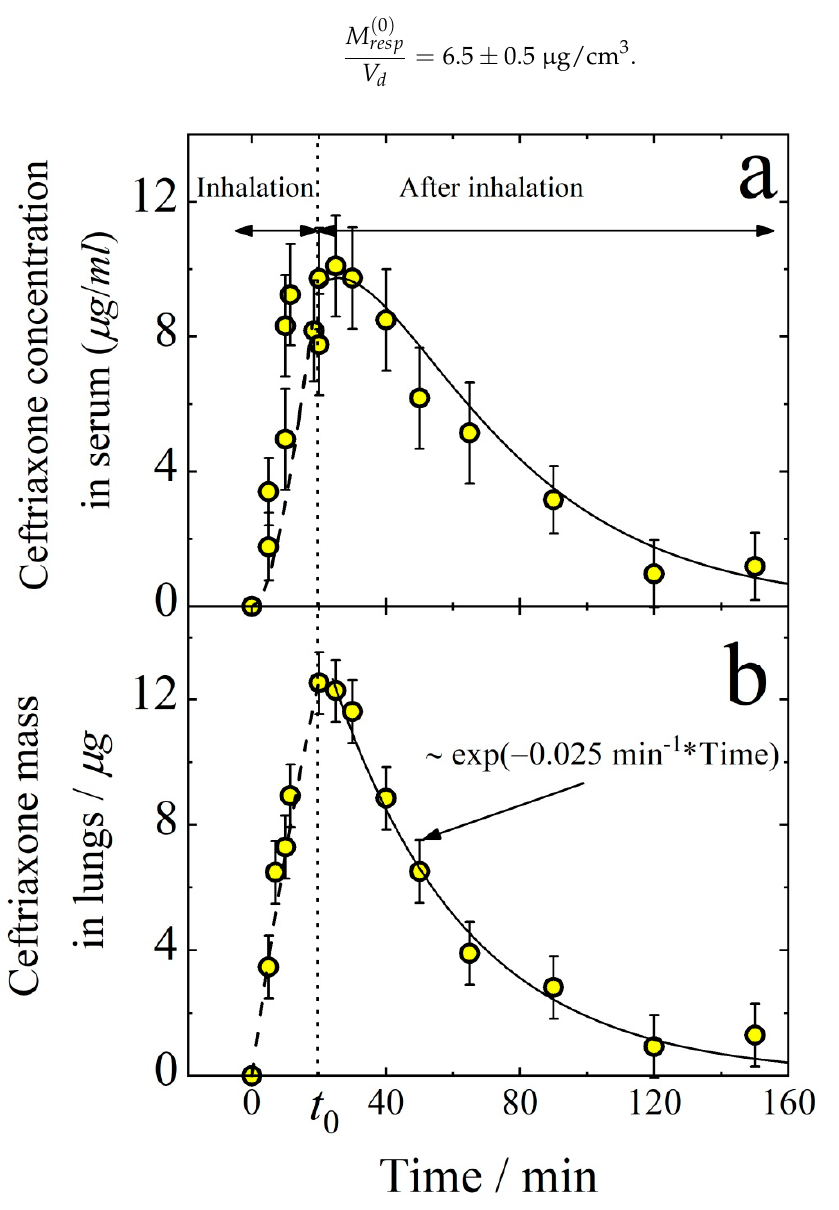
Figure 9. Ceftriaxone concentration in serum ( a ) and its mass in lungs ( b ) during and after inhalation. Aerosol mass concentration C A = 0.16 μ g/cm 3 , the mean particle diameter d = 1.4 μ m. Inhalation rate I Tot = 3.4 μ g/min. Solid and dashed lines in panel a follow Equations (24) and (21), respectively, solid and dashed lines in panel b follow an exponential decay and Equation (13), respectively. The dashed line in Figure 9a follows Equation (21) with k resp = 0.050 ± 0.005 min − 1 Table 1. Parameters determined from pharmacokinetic measurements for aerosol administration.